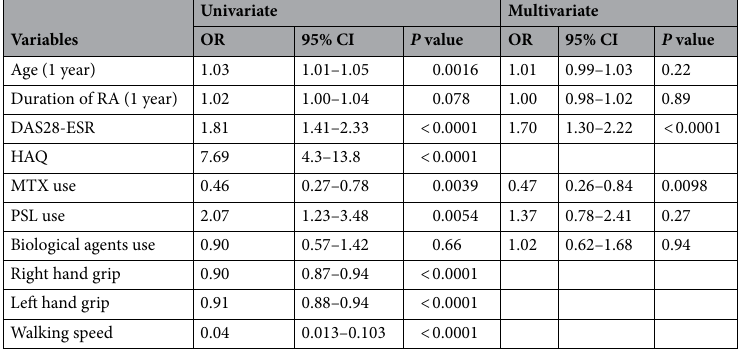
Table 3. Logistic analysis for RA patients with prefrailty or frailty. Results of univariate logistic (left) and multivariate logistic (right) regression analysis with RA-related factors regarding the presence of prefrailty or frailty. A dummy variable was constructed as follows: 0 = robust and 1 = prefrailty or frailty, and these regression analyses were performed with its frailty variable as a dependent variable. RA rheumatoid arthritis, DAS28-ESR 28-joint Disease Activity Score using erythrocyte sedimentation rate, HAQ health assessment questionnaire, MTX methotrexate, PSL